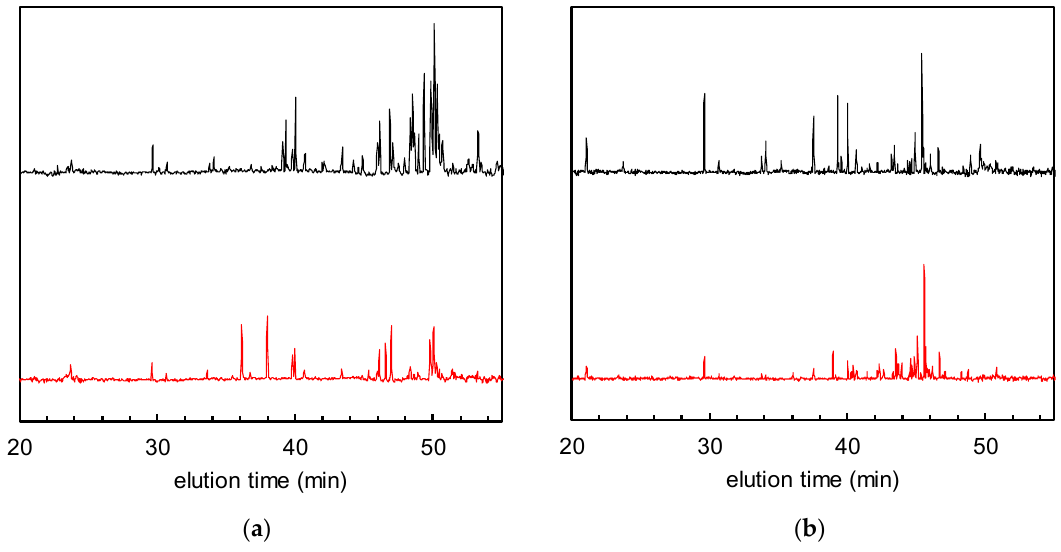
Figure 5. Gas chromatograms of solid ‐ phase ‐ extracted odour components after tobacco smoke adsorption (= 0 h of visible light irradiation) (black) and 24 h (red) of visible light irradiation. ( a ) Non ‐ woven fabric with Fe/TiO 2 ; ( b ) non ‐ woven fabric without Fe/TiO 2 . Figures 6 and 7 show the colour changes of a Fe/TiO 2 ‐ embedded fabric sample subject to visible light irradiation, and the time courses of TVOC concentrations and colour differences, respectively. The colour difference of the fabric after 0 h of irradiation compared to the initial colour was 10.4 (Figure 6, left end). After 24 h of visible light irradiation, the E * ab value decreased to 3.6 (Figure 6, right end; Figure 7a, blue line). This indicates that the tar constituents were also decomposed by visible ‐ light ‐ induced photocatalysis. On the other hand, the pristine non ‐ woven fabric shows a small colour change after 24 h of visible light irradiation ( E * ab dropped from 2.7 to 1.2, Figure 7b, blue line). Figure 6. Photographs of the non ‐ woven fabric with Fe/TiO 2 before tobacco smoke adsorption, after tobacco smoke adsorption (0 h) and after 2, 4, and 24 h of visible light irradiation. Catalysts 2019 , 9 , x FOR PEER REVIEW